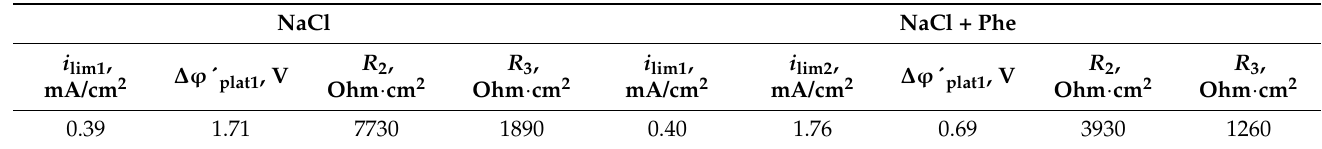
Table 1. Parameters of the CVCs of the cation-exchange membrane with a resin content of 45%